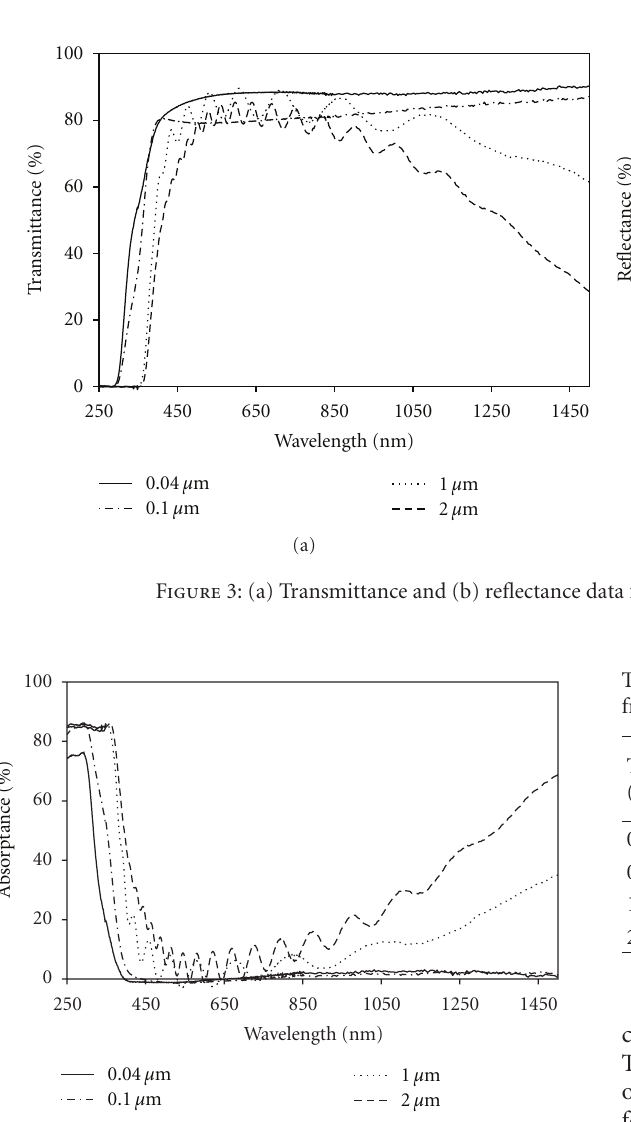
Figure 4: Absorbance data for the ZnO:Al 2 O 3 films of di ff erent thickness.